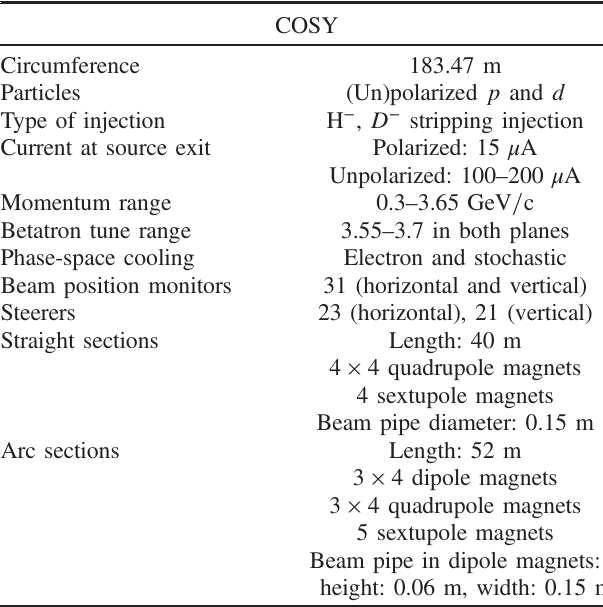
TABLE I. Main parameters of the COSY accelerator and storage ring